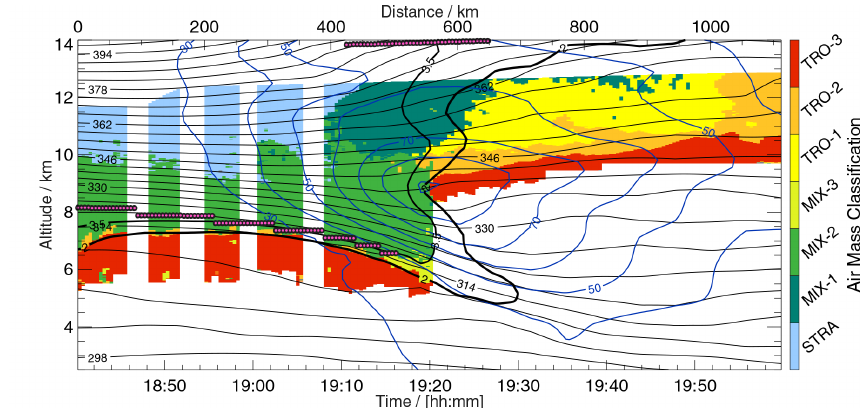
Figure 6. Collocated observations colored by the air mass classification in Fig. 4c. Superimposed model information as in Fig. 3 with an additional PV contour for 3.5 PVU. Pink circles mark the thermal tropopause according to the temperature lapse rate criterion (WMO,